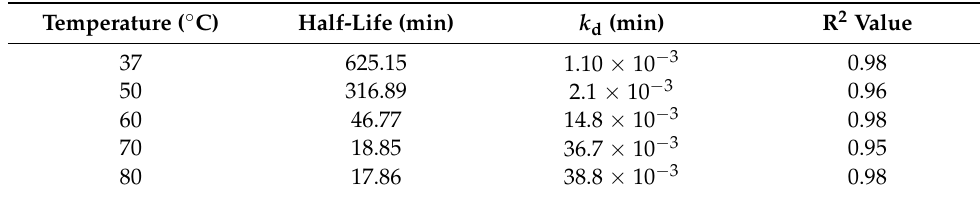
Figure 4. Thermostability assessment of His-tagged Pg -ASNase II. The thermostability of Pg -ASNase II was studied by incubating at 37–80 ◦ C temperatures for 90 min in Tris-HCl buffer (50.0 mM and 8.5 pH), and the residual Pg -ASNase II activity was calculated. The error bars represent the standard deviation of three experiments. Table 2. Half-life time ( t 1/2 ) and heat deactivation constant ( k d ) of Pg -ASNase II produced by Pseudomonas sp. PCH199.